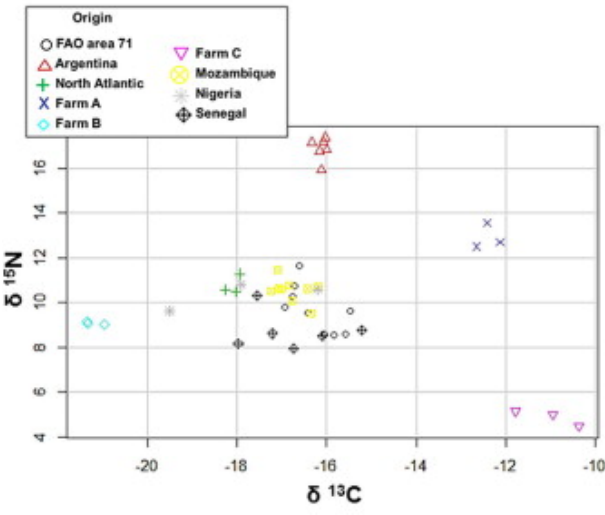
Figure 7. Scatterplots of C and N isotope ratio analysis for origin assessment (Source: [52]).